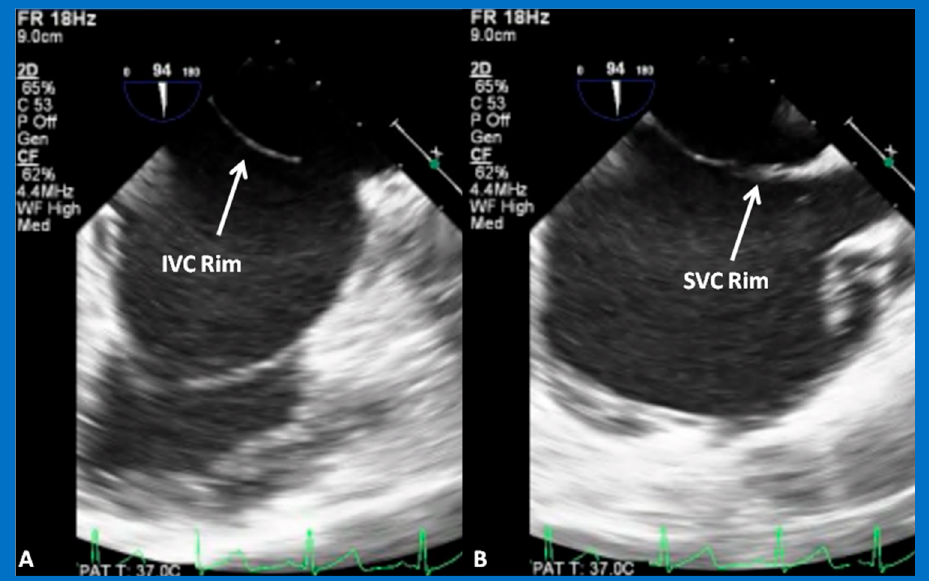
Figure 17. Transesophageal echocardiographic (TEE) study of an atrial septal defect demonstrating adequate-sized inferior vena caval (IVC) ( A ) and superior vena caval (SVC) ( B ) rims.